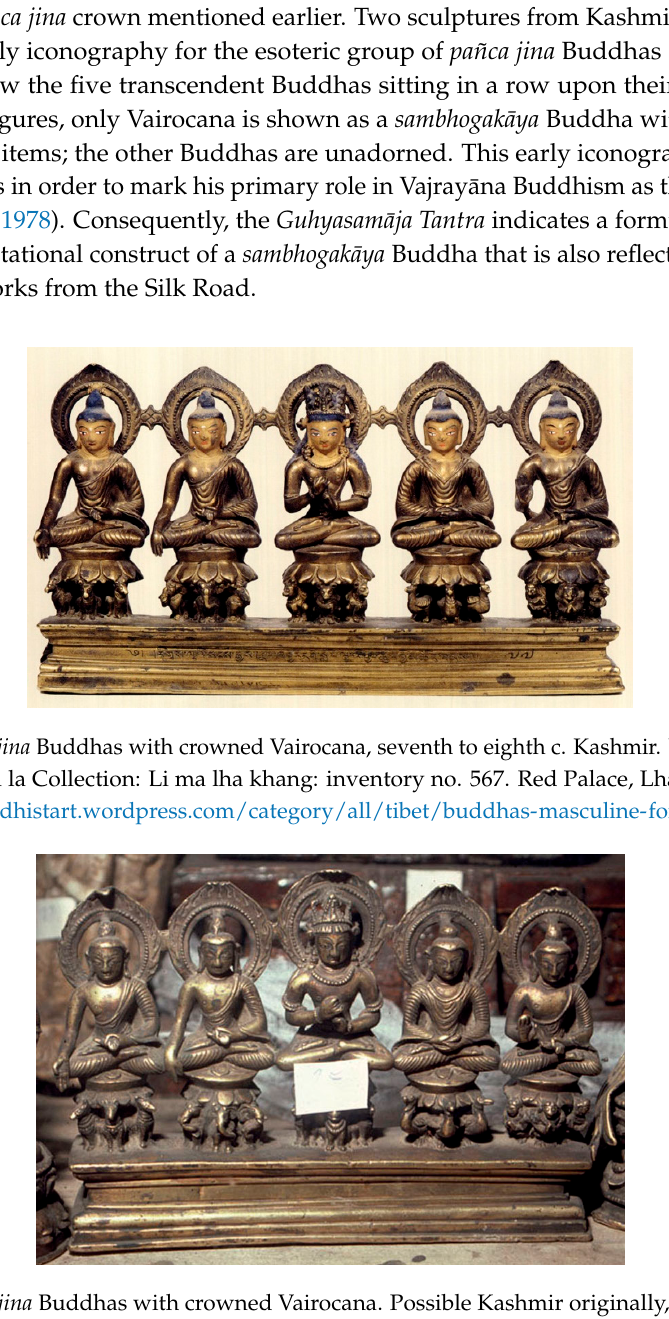
Figure 25. Pa ῆ ca jina Buddhas with crowned Vairocana. Possible Kashmir originally, now in Ladakh, Tibet, seventh to eighth c. Brass. Photograph courtesy of John C. Huntington.